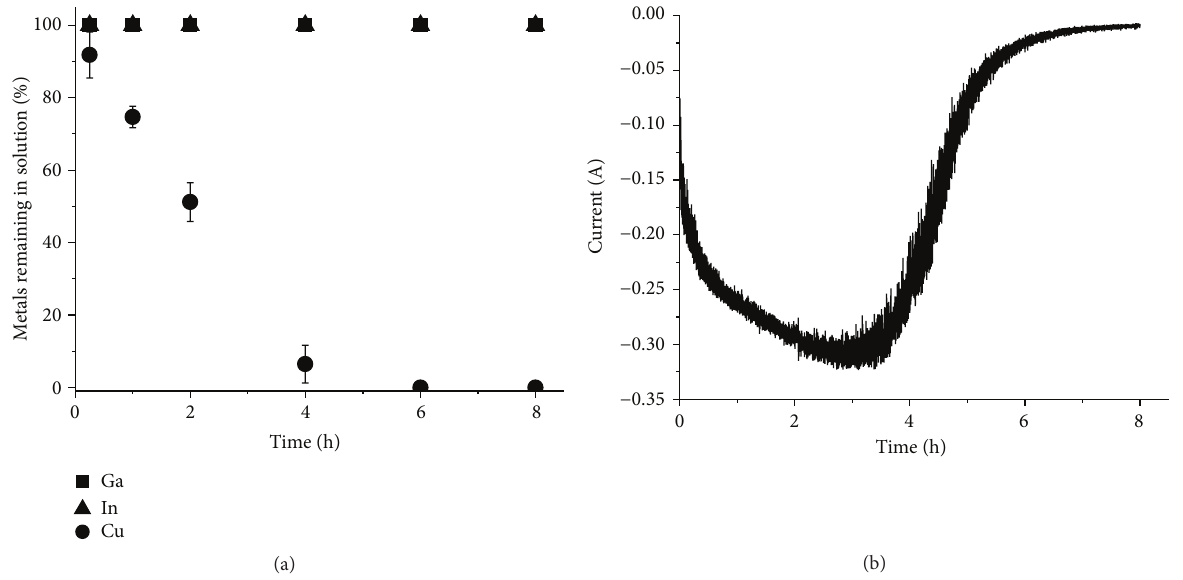
Figure 5: Electrochemical separation of copper from Solution 1. (a) The metal concentration in the solution relative to the original concentration as a function of time. (b) The current passed through the circuit as a function of time.